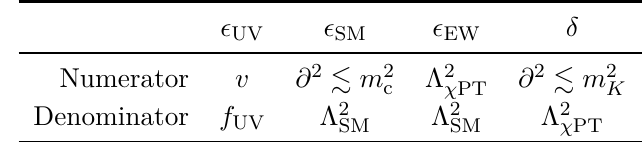
Table 7. Small parameters that are defined as ratios between the relevant UV, SM, and χ PT scales. The small parameter δ also captures the expansion in n − 1 Λ = 4 πf are defined such that they include NDA loop factors. For momenta ∂ 2 . m 2 χ PT 0 has (cid:15) = δ(cid:15) SM EW